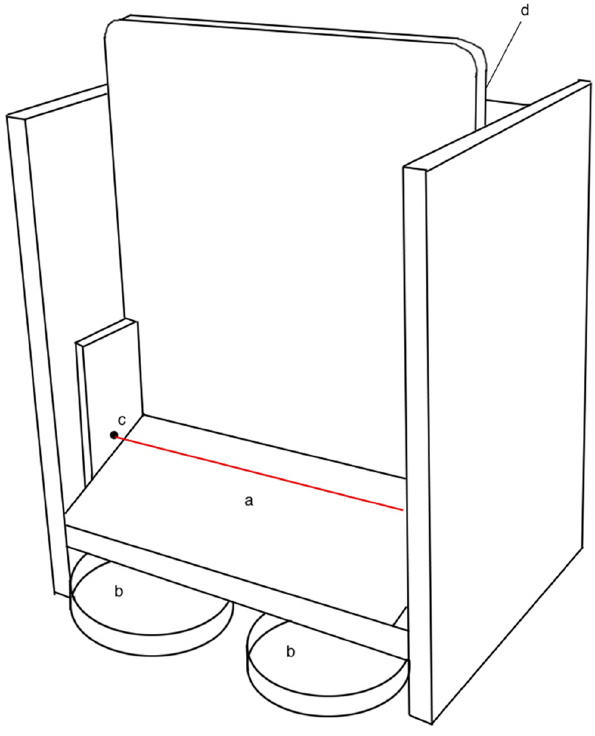
Figure 1. A diagram of the apparatus used in the study. a=target, b=milk and water trays, c=photointerruptor shown with a red line, d=LCD screen and controls (not visible). Trays are stowed under the target zone for ease of transport, but are moved out in front of the target when in use.